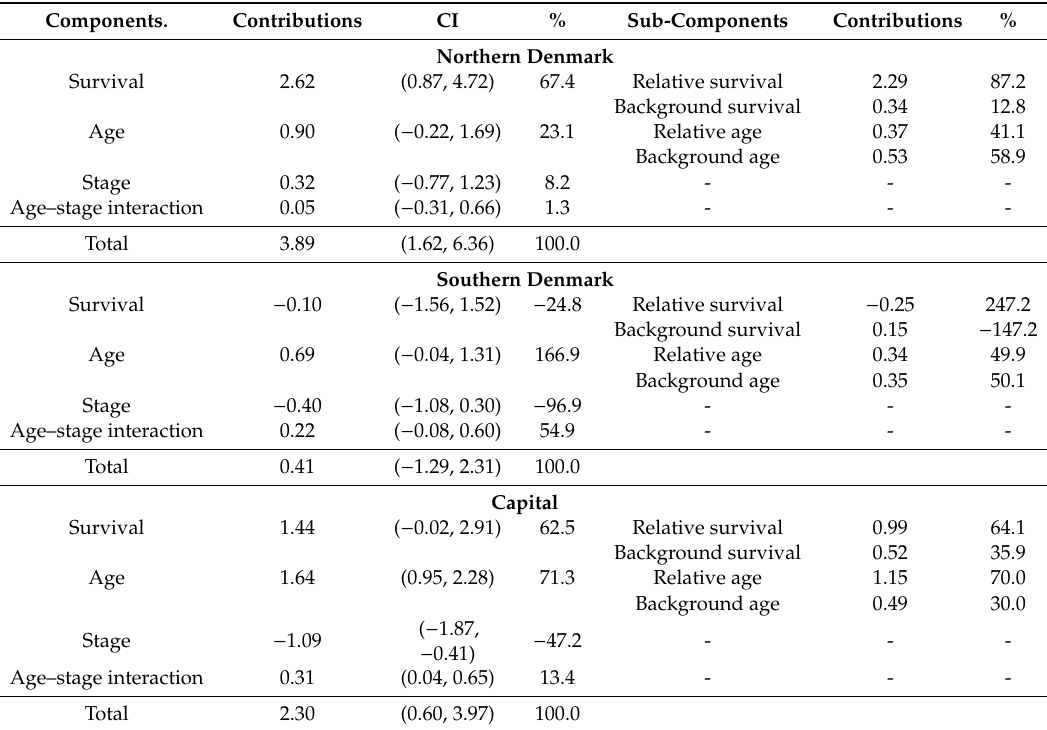
Table A2. Five-year crude survival decomposition between Central Denmark and three other Danish regions, females diagnosed with breast cancer between 2008 and 2010.